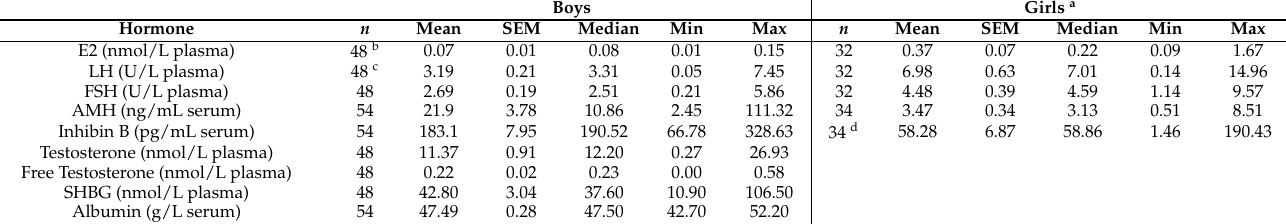
Table 3. Levels of reproductive hormones in plasma and serum of 13–15-year-old